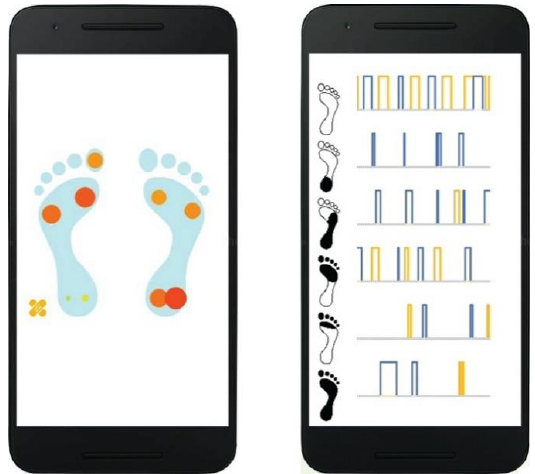
Figure 3. Gait data visualizations. On the left, the pressure data are visualized in real time. The amount of pressure is translated into a certain circle size and color (high pressure is a large red circle, and low pressure is a small yellow circle). On the right, the active/non-active gait subphases are real-time visualized in a time graph. The black colored areas of the foot sole represent where pressure is detected for the given gait subphase. On the left, the traumatized leg is indicated with a plaster. On the right, the traumatized leg is colored orange while the good leg is colored blue.